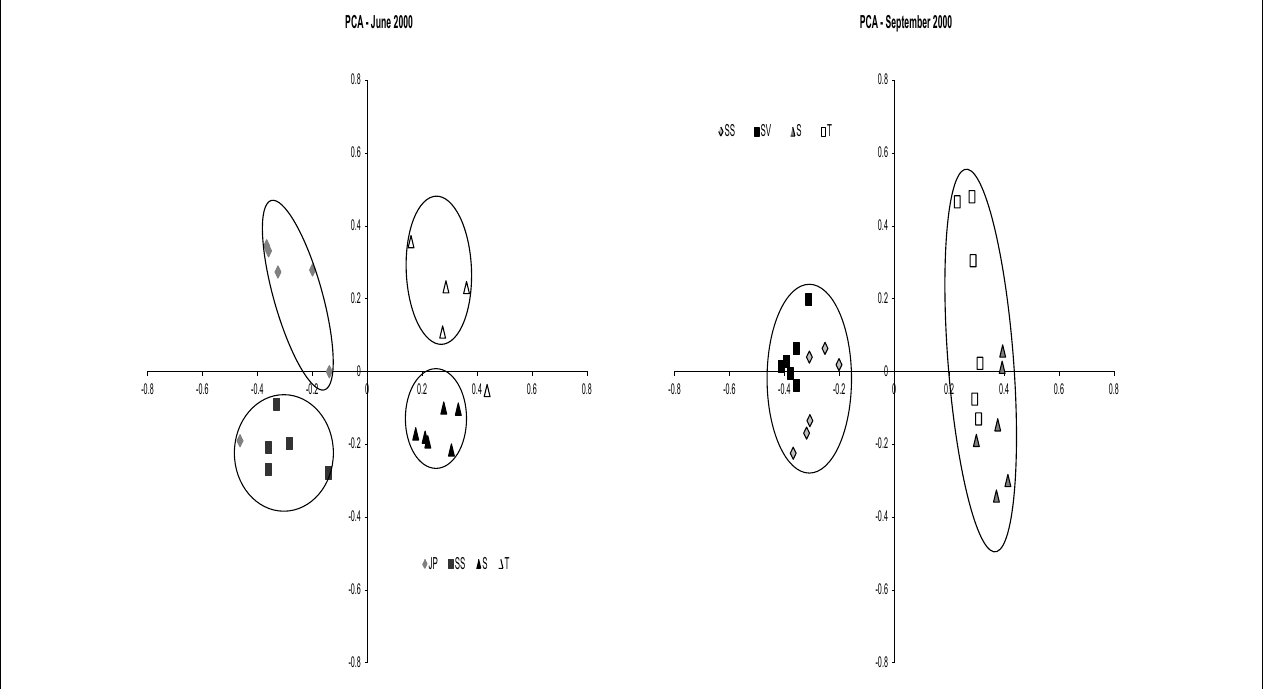
variance and Axis 2 represents 14.7% of the variance. For September 2000 Axis 1 represents 31.5% of the variance and Axis 2 represents 11.5% of the variance. Reproduced with kind permission from Davis et al. (2011), Figure